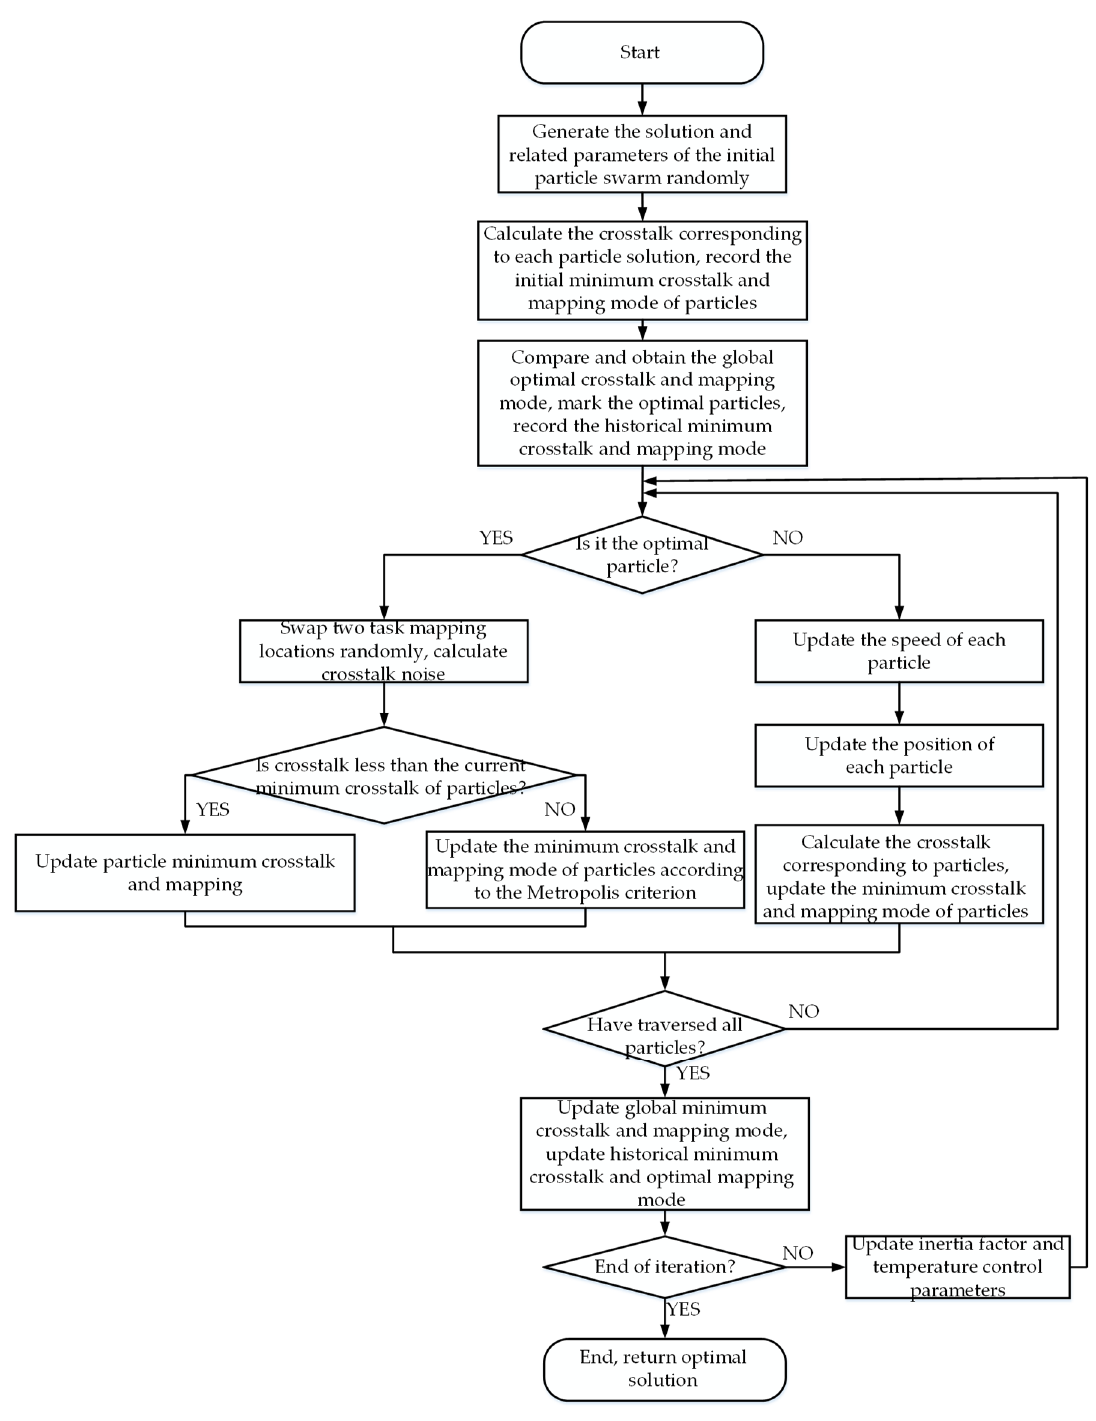
Figure 5. Crosstalk optimization process.